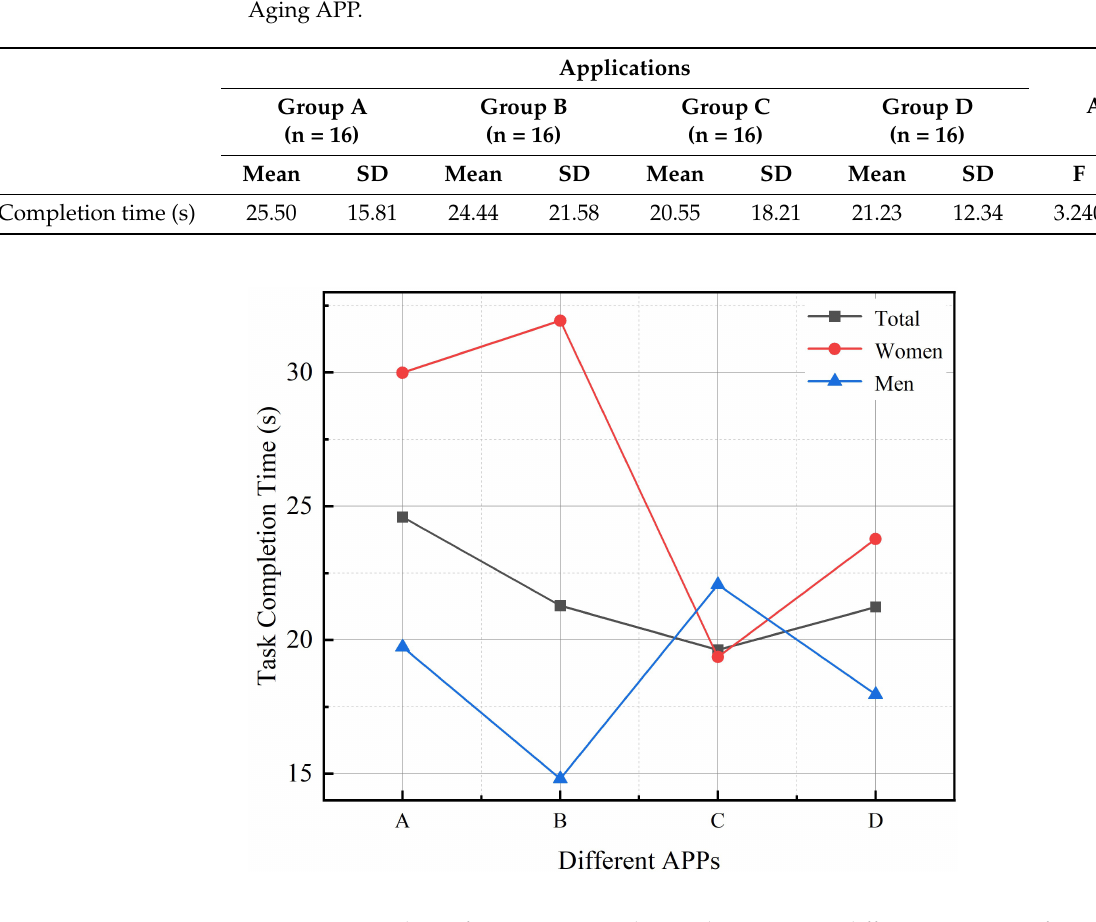
Figure 3. Line chart of participants’ task completion time in different Apps: A refers to C-life Senior Care APP; B refers to Senior Living APP; C refers to Senior Care Manager APP; D refers to Smart Aging